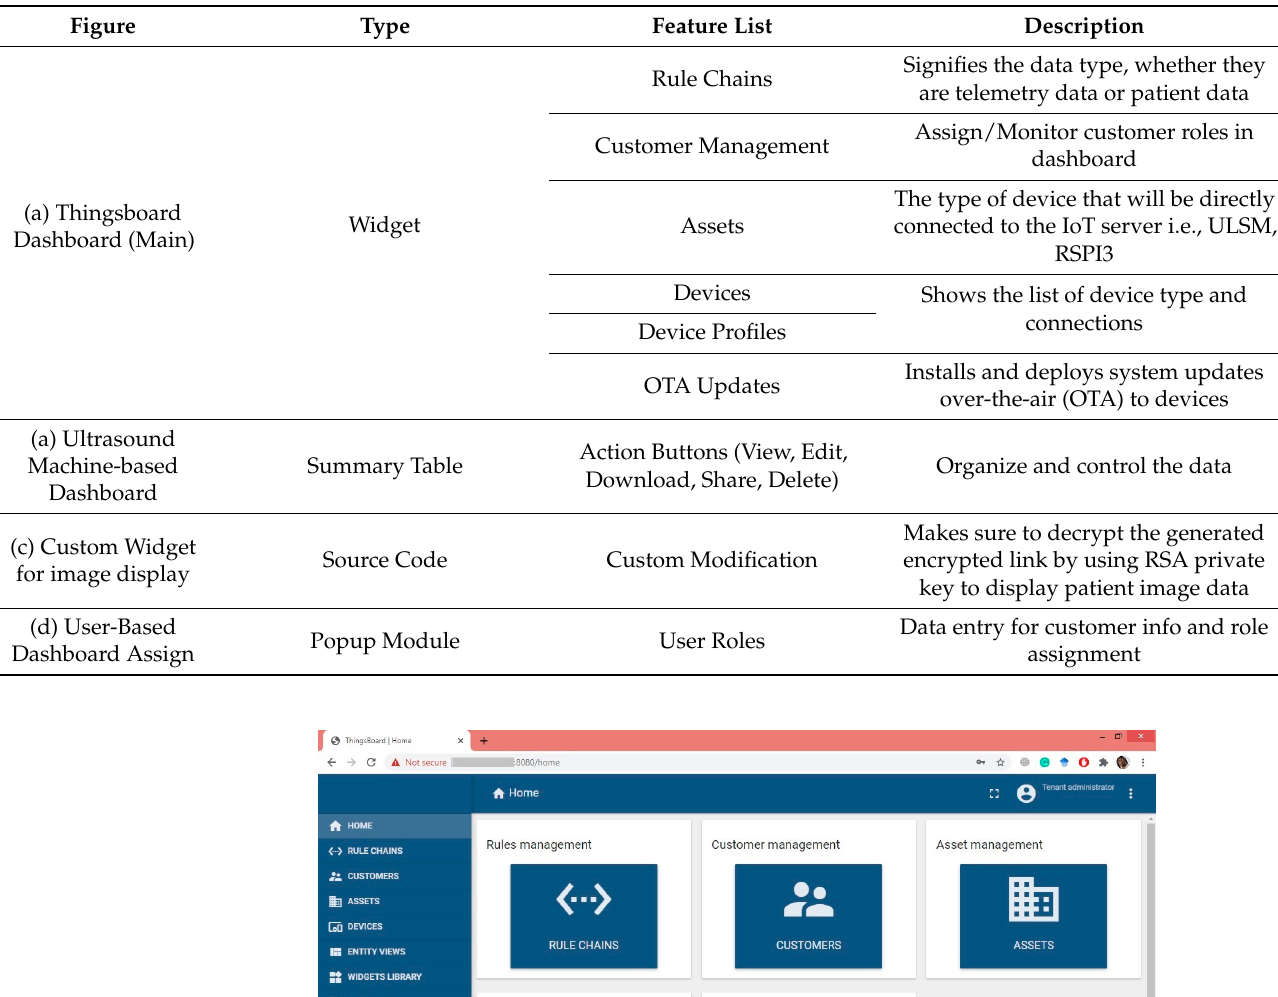
Table 1. Thingsboard configuration summary (based on Figure 10).